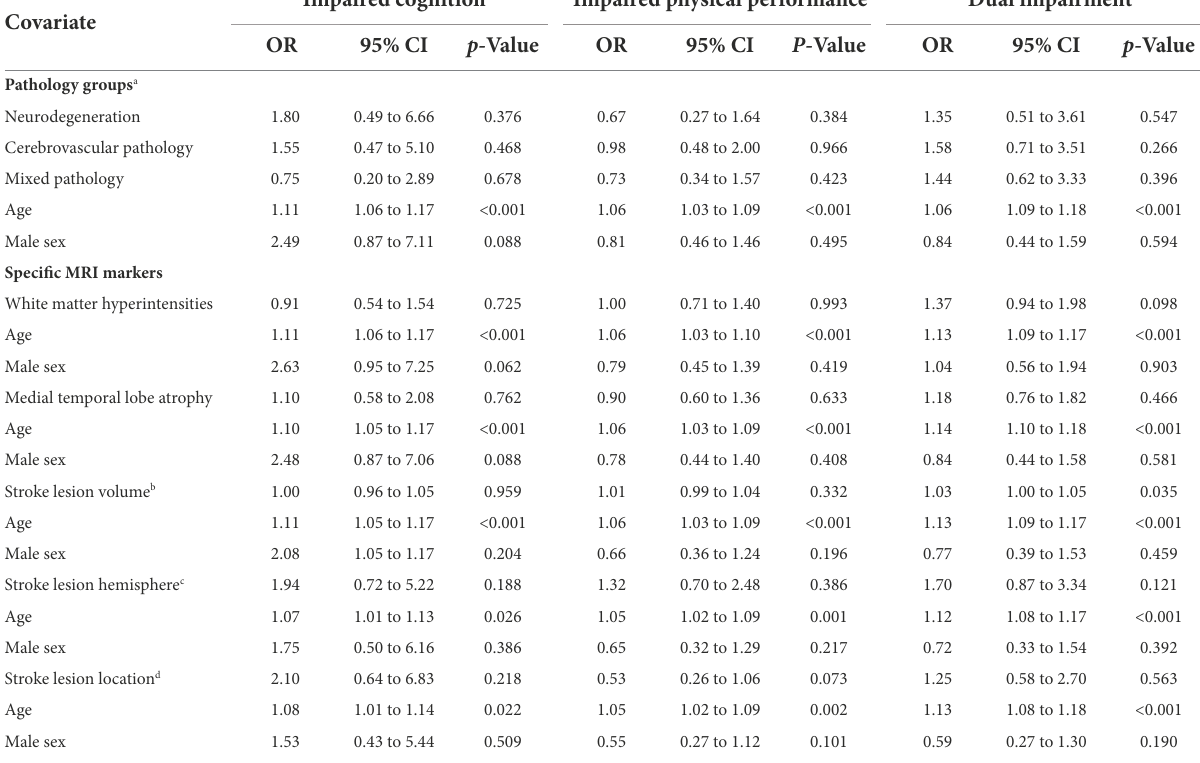
TABLE 4 Multinominal logistic regression, one covariate at a time adjusted for age and sex.